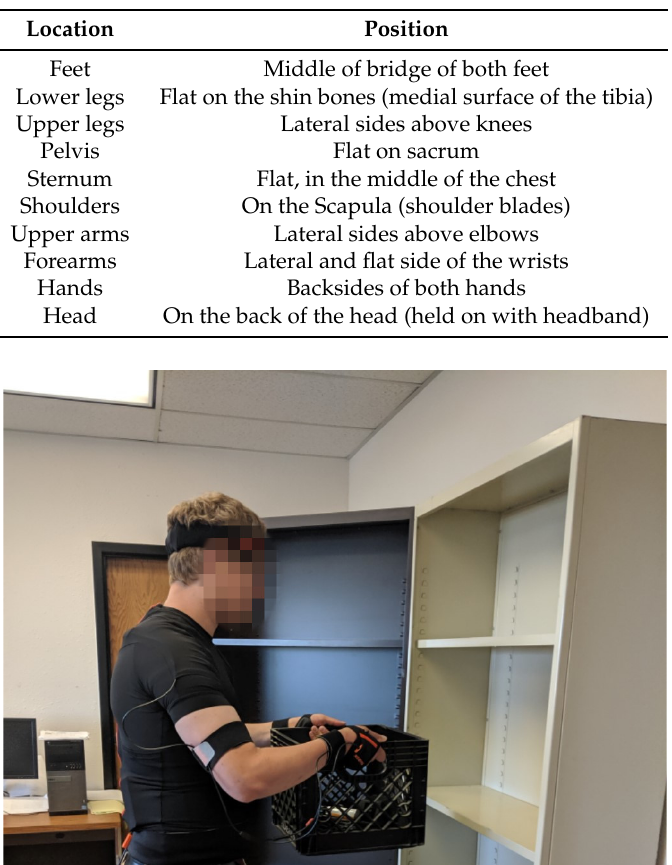
Table 1. The body positions of the Xsens IMU trackers.